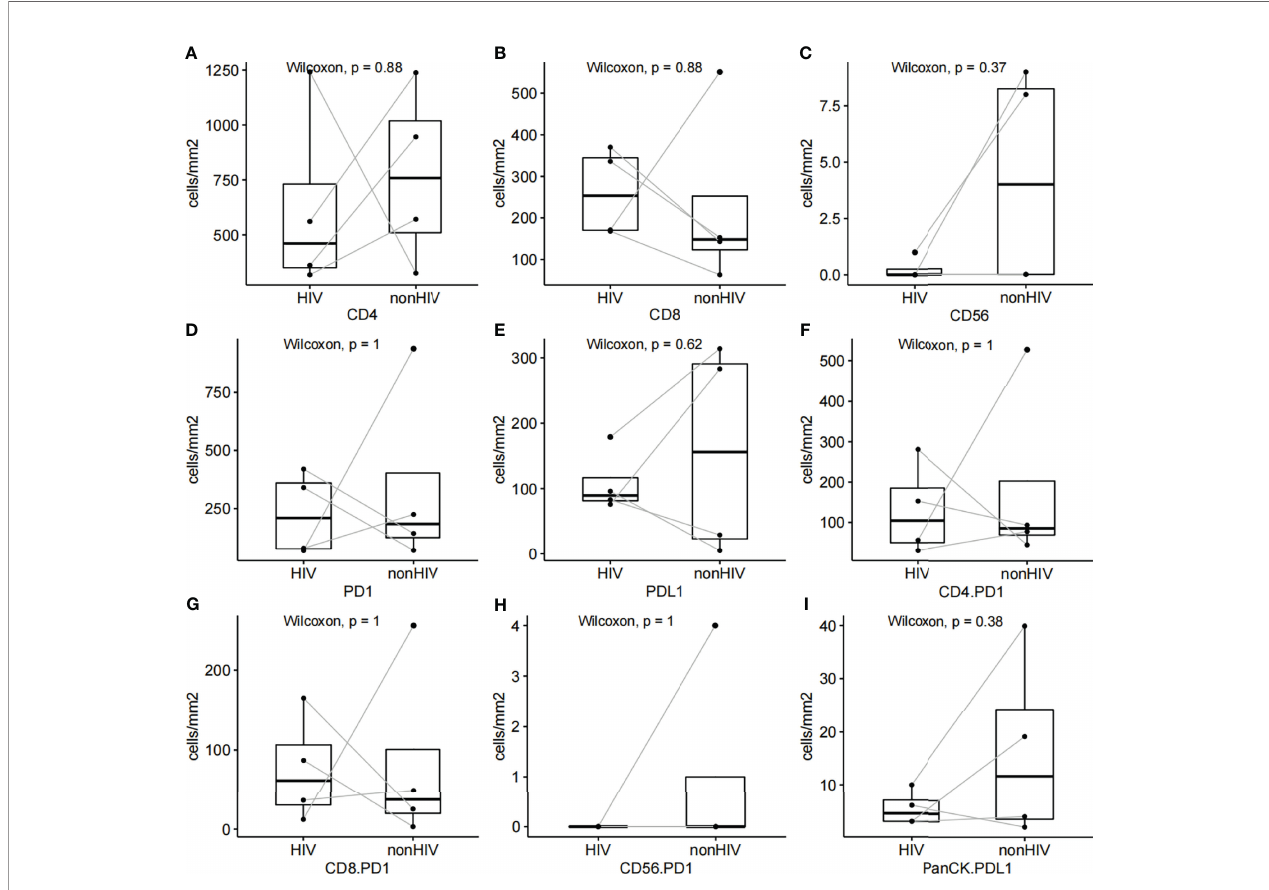
FIGURE 2 | (A – E) Pairing test for relative CD4, CD8, CD56, PD-1, and PD-L1 cell densities between HIV-infected and non-HIV-infected CRC samples. (F – H) Pairing test of PD-1 positive CD4, CD8, CD56 cell densities between HIV-infected and non-HIV-infected CRC samples. (I) Pairing test of PD-L1 positive tumor cell densities between HIV-infected and non-HIV-infected CRC